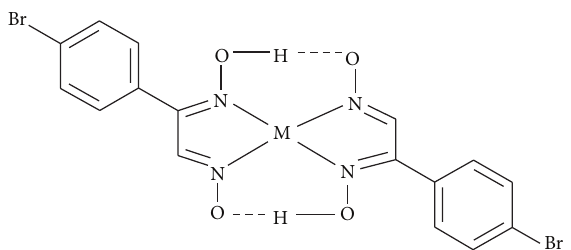
Figure 2: Metal complexes of the ligand [M = Ni(II), Cu(II), and